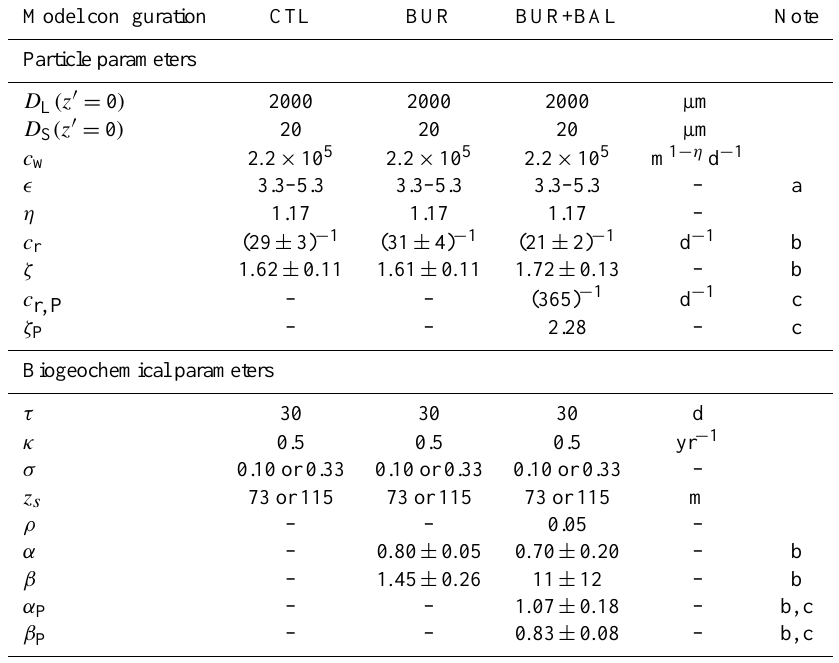
Table 1. Parameters of PRiSM (Eq. 13) and the biogeochemical models used to simulate the oceanic P cycle: CTL (control simulation without P burial or allochthonous P inputs), BUR (with P burial and allochthonous P inputs), and BUR+BAL (as BUR, but including effects of ballast-protected sinking